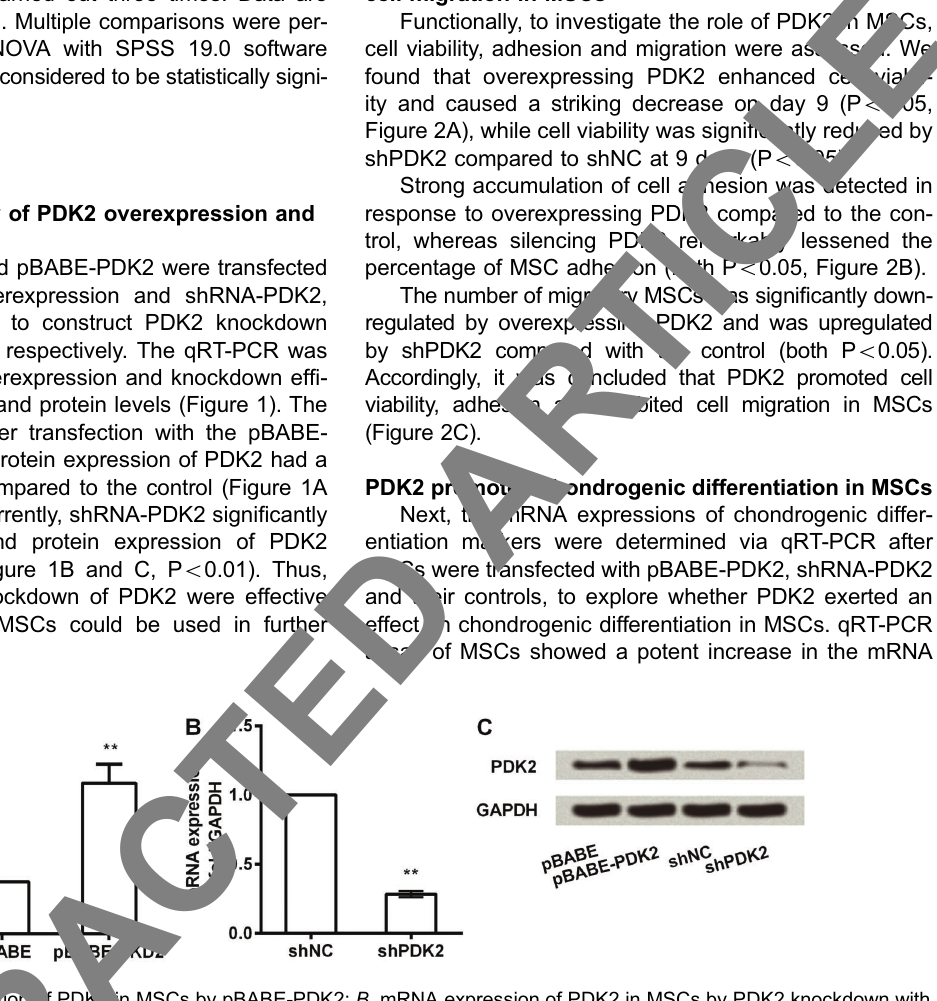
Figure 1. A , mRNA expression of PDK2 in MSCs by pBABE-PDK2; B , mRNA expression of PDK2 in MSCs by PDK2 knockdown with shPDK2; C , Protein expression of PDK2 in MSCs by PDK2 overexpression and knockdown. PDK2: pyruvate dehydrogenase kinase isoform 2; sh: short hairpin; NC: negative control; GAPDH: glyceraldehyde-3-phosphate dehydrogenase; MSC: mesenchymal stem cell. **P o 0.01 (ANOVA).